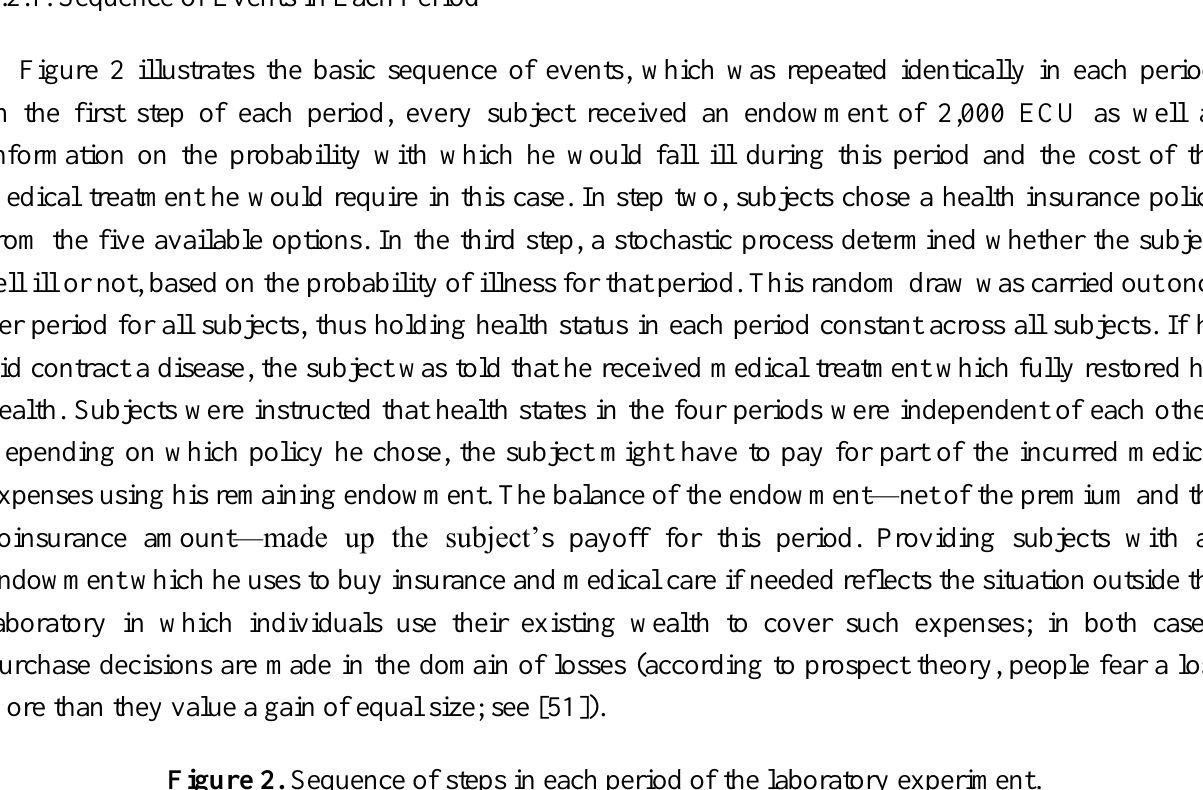
Figure 2. Sequence of steps in each period of the laboratory